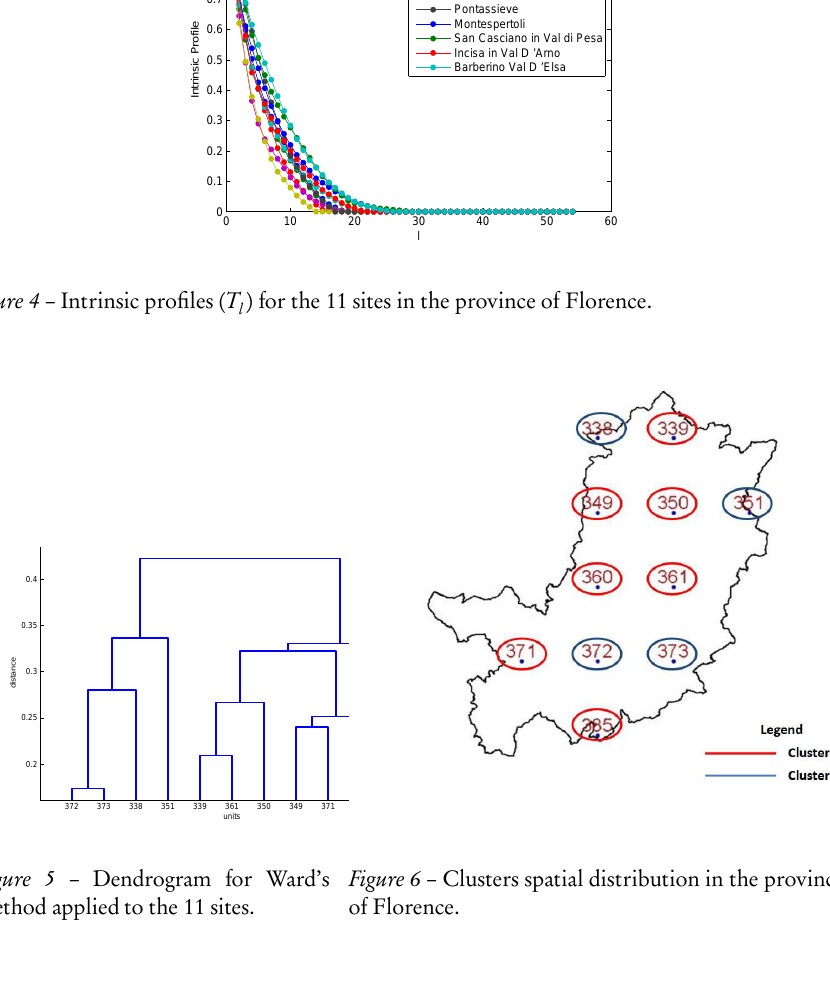
Figure 6 – Clusters spatial distribution in the province of